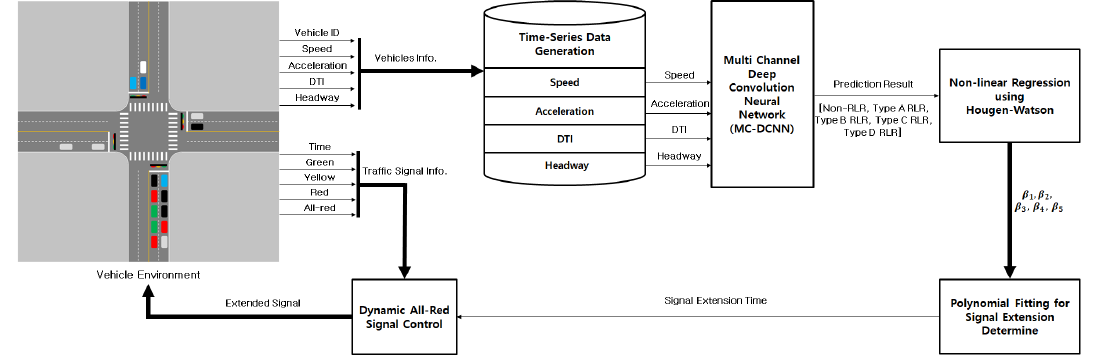
Figure 1. The proposed dynamic all-red signal control